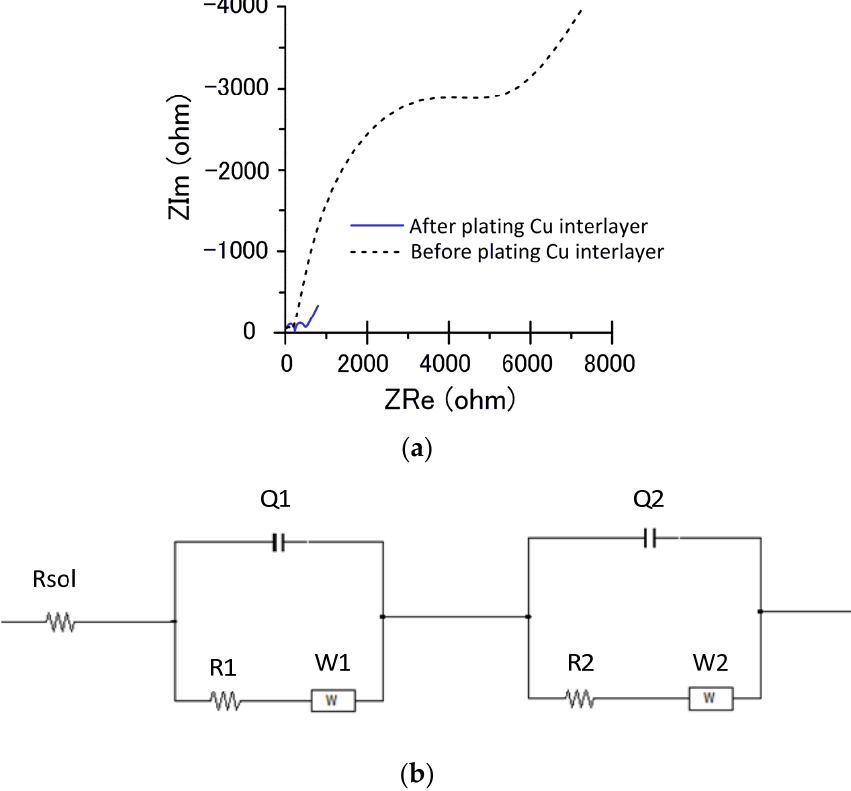
Figure 4. Impedance spectroscopy before and after a plated Cu interlayer and its equivalent circuit. ( a ) Impedance spec- troscopy, and ( b ) equivalent circuit. Table 3. Electrochemical impedance values before and after a plated Cu interlayer.